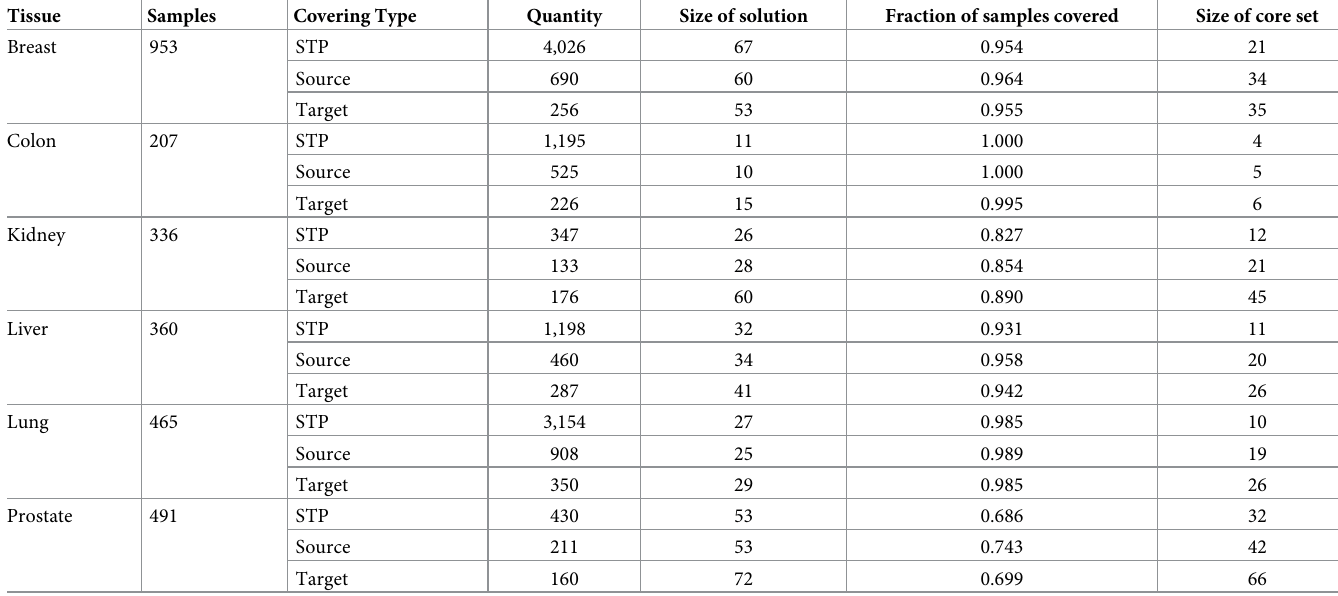
Table 5. Statistics of optimal coverings. For each of the six tissues, this table provides basic information about the optimal coverings at all levels: STP, source with target, target with source. For instance, for breast cancer, there are 4,026 candidate STPs after both filters (rejecting source-target independence and 2% tissue sample frequency); the minimal covering size is 67 STPs; at least one of these 67 STPs is aberrant in 95.4% of the breast cancer samples; and there are 21 STPs which appear in every minimal covering. Tissue